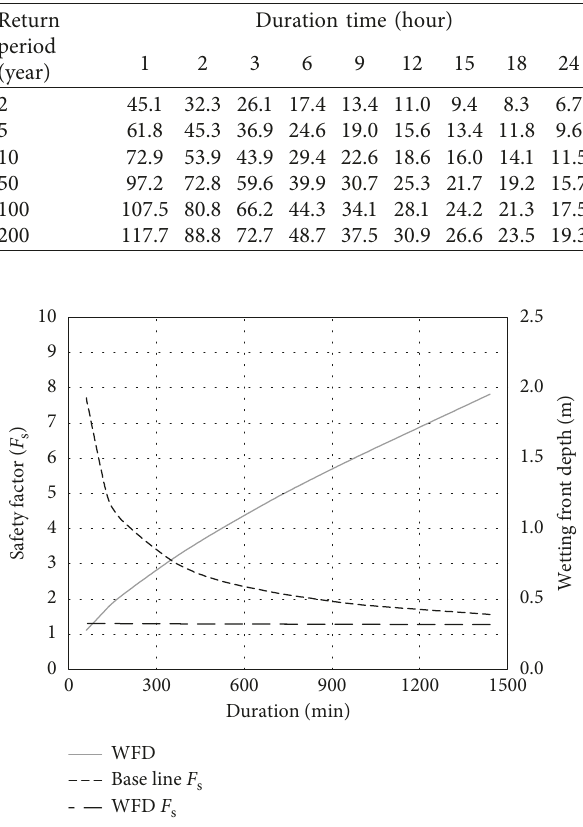
Figure 9: Change in wetting front depth and factor of safety depending on rainfall duration using a deterministic